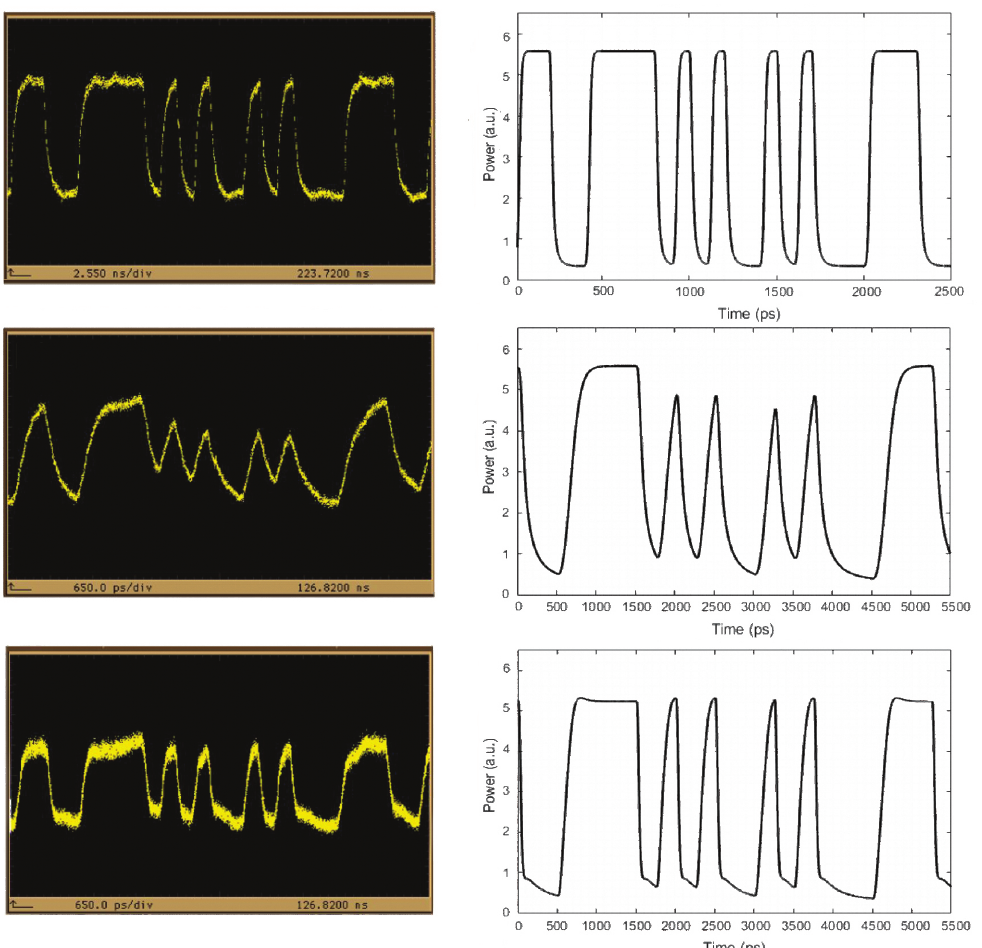
Figure 4. Encoded signal waveforms. Upper row : RSOA output at 1 Gb/s. Middle row : RSOA output at 4 Gb/s. Lower row : BFL output at 4 Gb/s. Left column : Experimental results. Right column : Simulation results. Experimental results time scale— Upper row : 2.55 ns/div; Middle row : 650 ps/div; and Lower row : 650